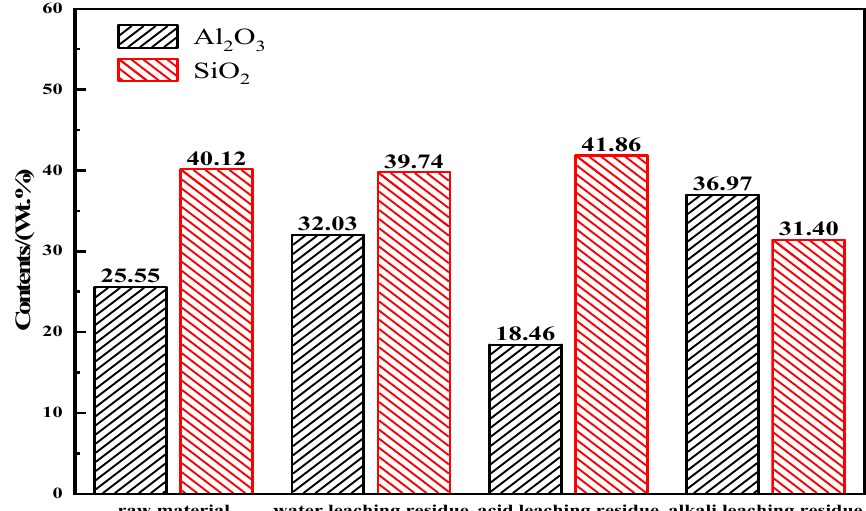
Figure 3. Compositions of water, acid, and alkali leaching residue.